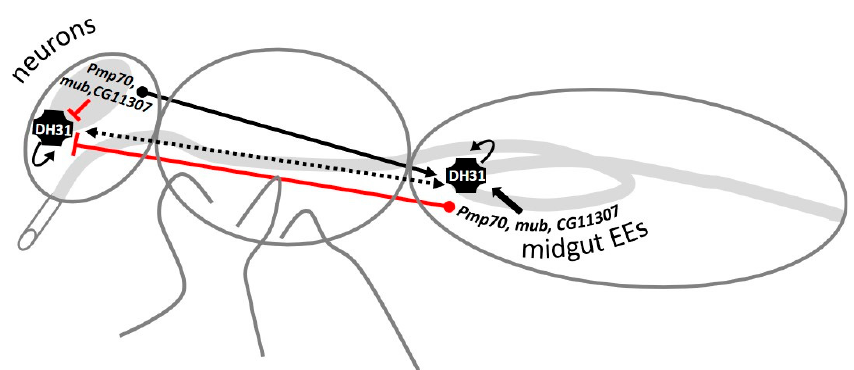
Figure 10. Pmp70 , mub and CG11307 , control Dh31 positively in the midgut and negatively in the head, irrespective of the tissue being targeted for downregulation (midgut EEs or neurons). Proposed mechanism depicting the communication between GWAS ‐ identified genes and Dh31 along the gut ‐ brain axis. While a positive regulator of defecation rate, Dh31 is induced in the midgut via Pmp70 , mub , CG11307 expression in EEs or neurons. Interestingly, Dh31 is inhibited in the head via Pmp70 , mub , CG11307 expression in EEs or neurons. However, Dh31 positively regulates itself, locally and remotely, in the midgut and head tissues, when expressed in either midgut EEs or neurons. Red lines on the diagram represent negative regulation while the black arrows represent positive regulation of defecation rate.